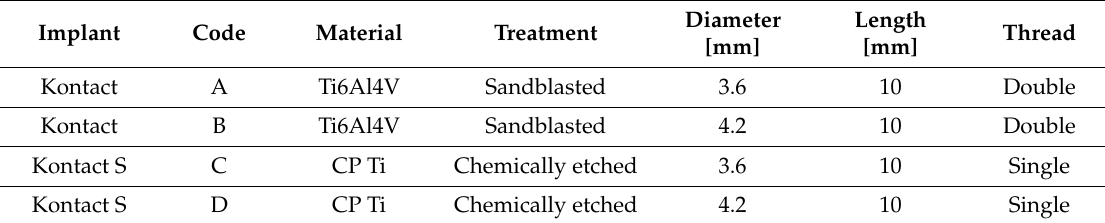
Table 1. Main characteristics of the fixtures under